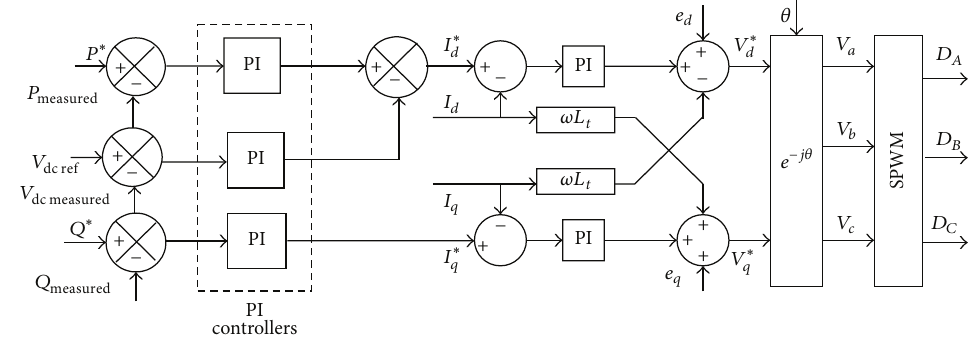
Figure 4: Grid side inverter